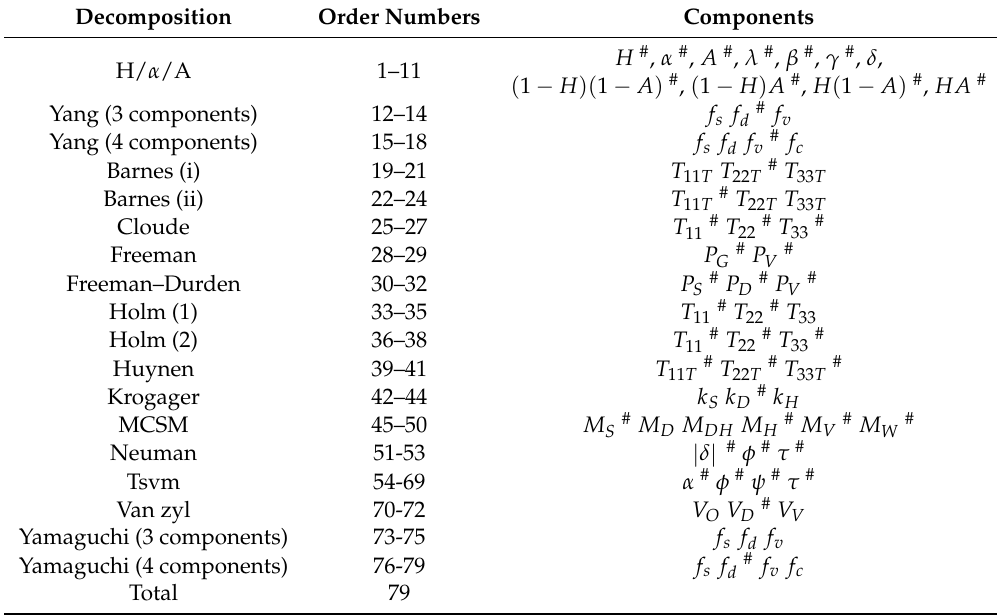
Table 1. The target decomposition features. MCSM, multiple-component scattering